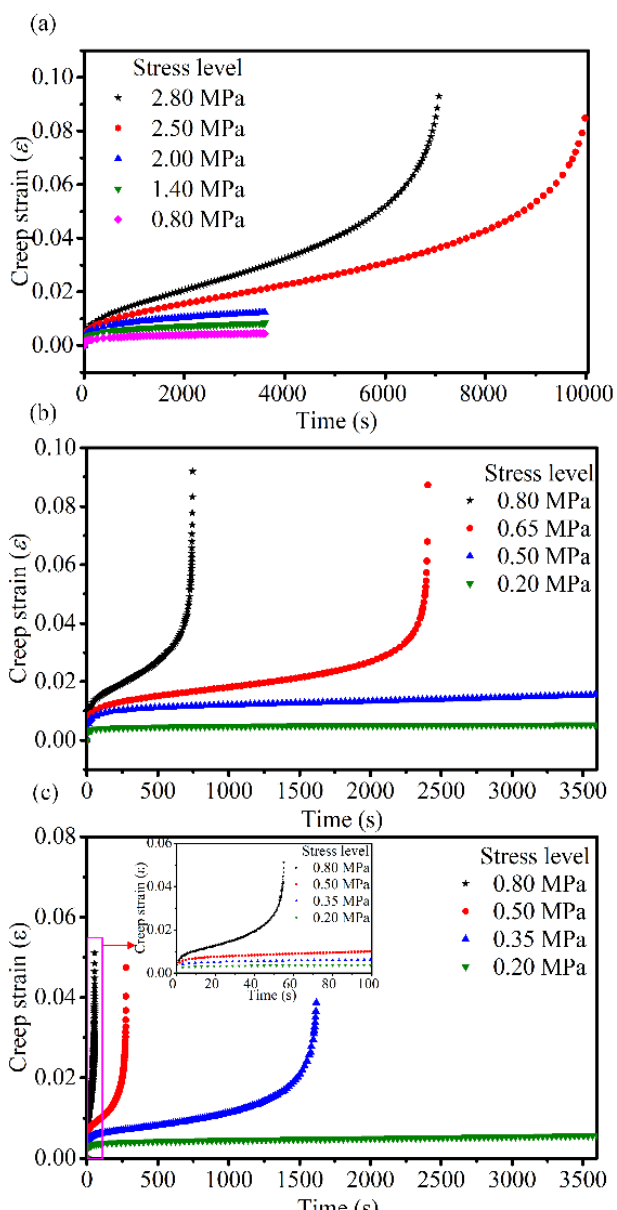
Figure 5. Creep strain curves of asphalt mixtures under different stress levels at ( a ) 10 °C, ( b ) 30 °C, and ( c ) 50 °C.